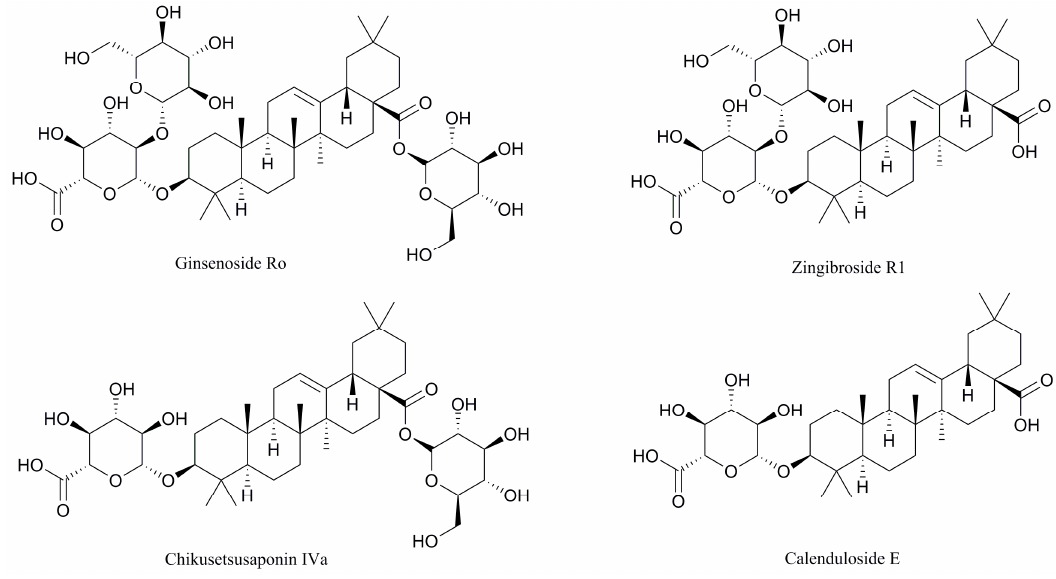
Figure 5. Structures of Ro, R1, IVa, and E.